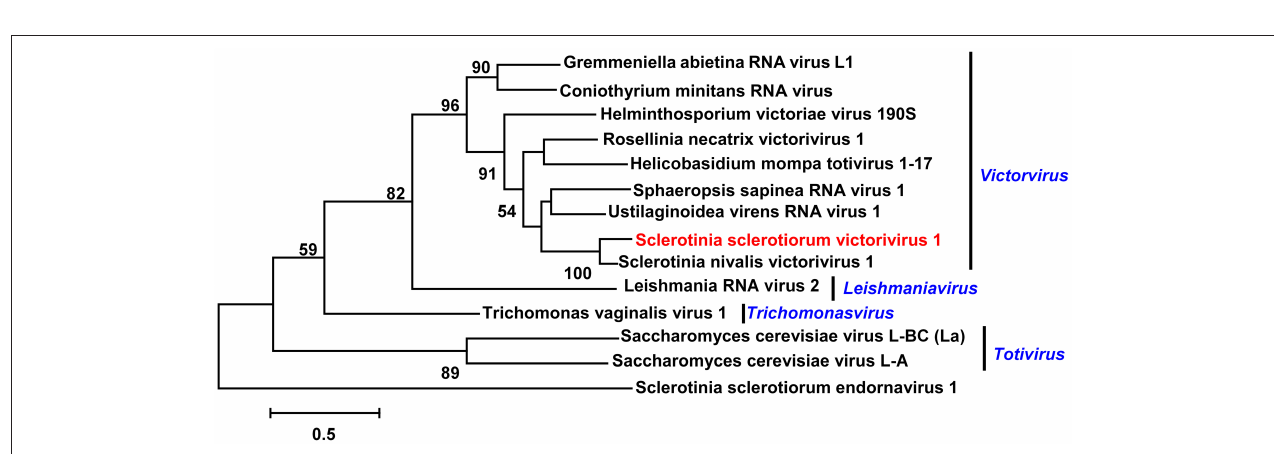
FIGURE 2 | Phylogenetic analysis of the putative virus in Family Totiviridae . Phylogenetic analysis of the putative Sclerotinia sclerotiorum victorivirus 1 with other selected viruses in Family Totiviridae based on viral RdRp amino acid sequences. Branch lengths are scaled to the expected underlying number of amino acid substitutions per site. If not specifically addressed, the alignments of RdRp amino acid sequences were performed by ClustalW, and phylogenetic tree was constructed using MEGA7.0.18, and selected viruses are listed in Table S4. Viruses marked with red color are found in Australian isolates of Sclerotinia sclerotiorum . Sclerotinia sclerotiorum endornavirus 1 was as the